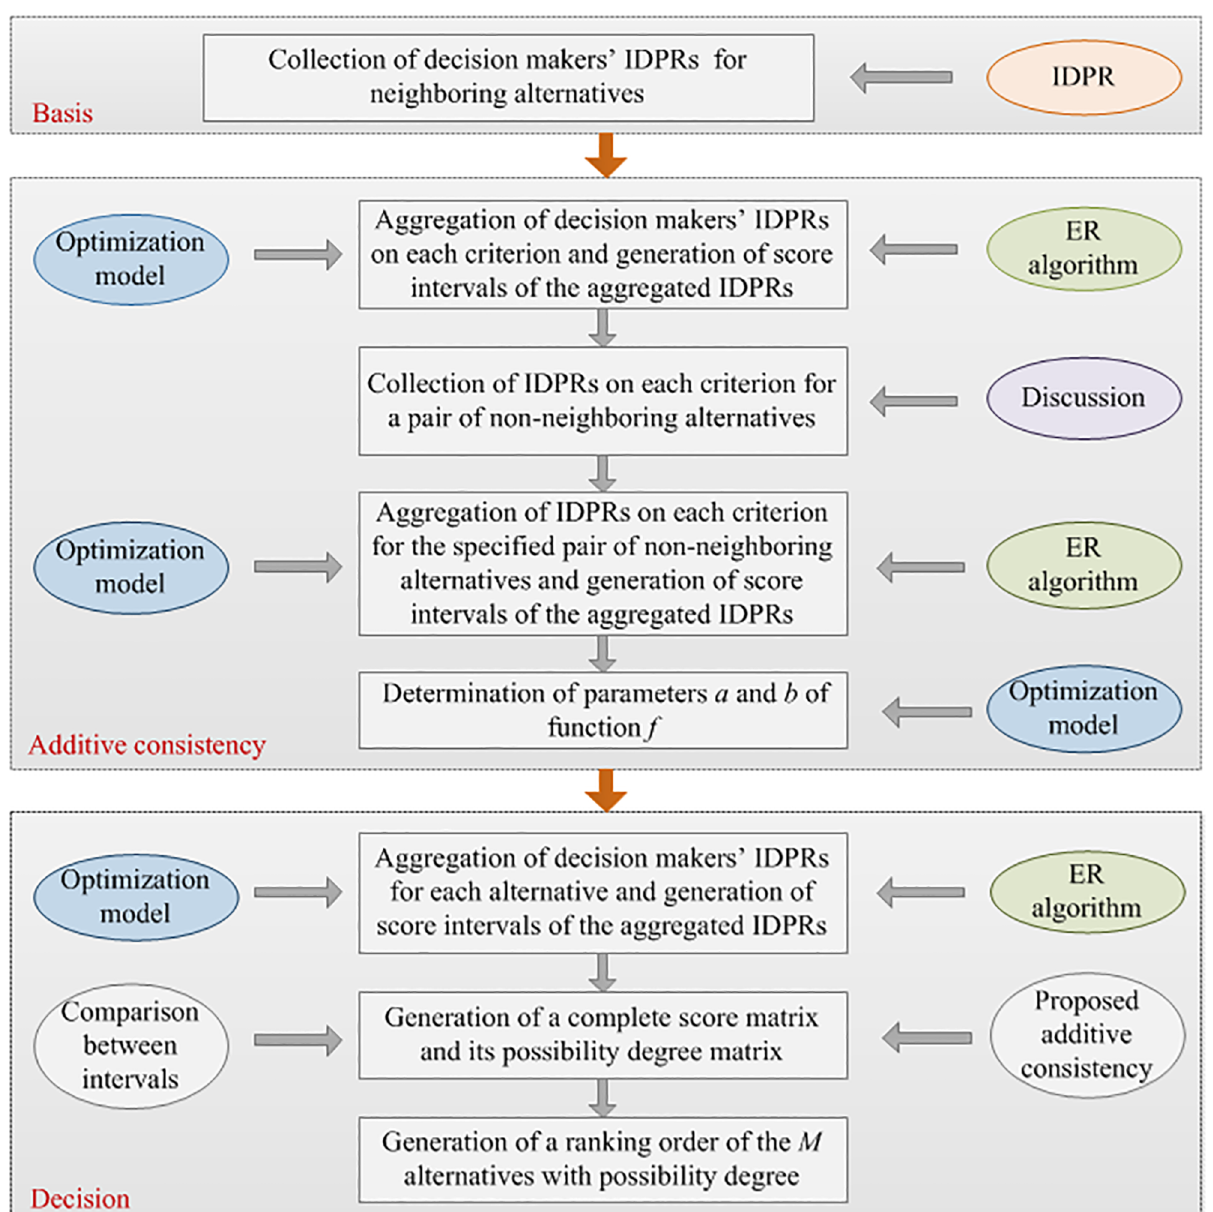
Fig 1. Process of generating a solution to the MCGDM problem with